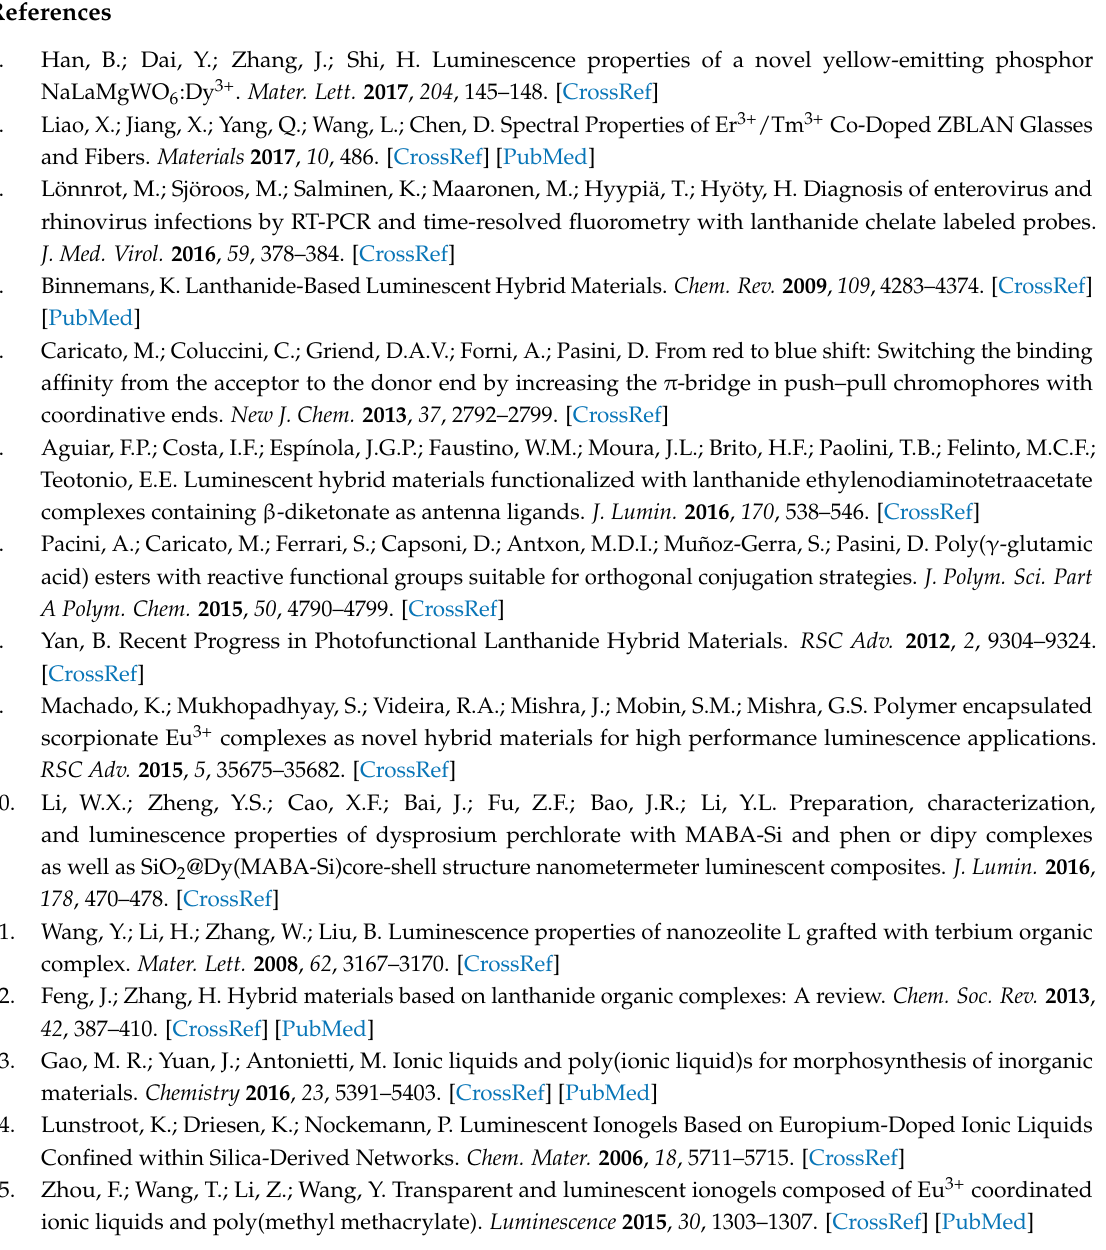
Figure S1: XRD patterns of MCM-41 and the final materials; Figure S2: TEM of the Eu@MCM-41-P (IL-AA). Author Contributions: Xiaolong Zheng and Meiyu Wang performed the experiments; Qiuping Li conceived and designed the experiments, analyzed the data, and wrote the paper. Funding: This research was funded by the Natural Science Foundation of Zhejiang Province (LQ14B010001) and the Natural Science Foundation of Ningbo